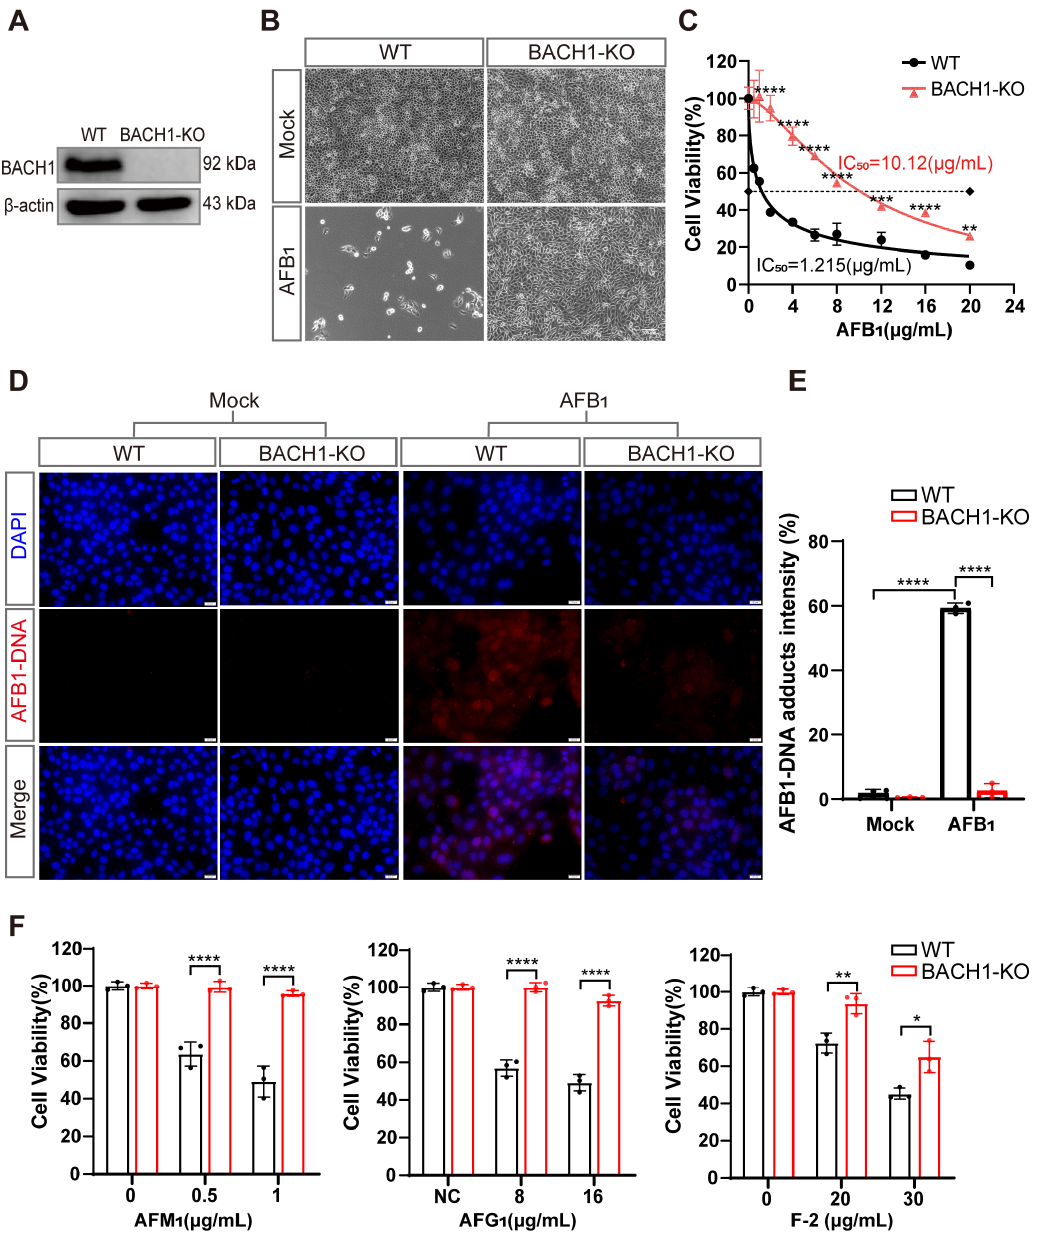
Figure 2. BACH1 knockout cells exhibit higher resistance to aflatoxin B 1 . ( A ) Western blot analysis of BACH1 expression in WT and KO cells. ( B ) Representative images of WT and BACH1-KO PK-15 cells challenged with 2 μ g/mL AFB 1 for 48 h. Scale bar, 100 μ M. ( C ) The IC 50 values for AFB 1 in WT and BACH1-KO cells determined by CCK-8 assays. ( D , E ) Immunofluorescence staining of AFB 1 -induced DNA adduct formation in WT and BACH1-KO cells; relative fluorescence intensity calculated using ImageJ software. Scale bar, 20 μ M. ( F ) Enhanced resistance to AFM 1 , AFG 1 , and F-2 in BACH1-KO cells. WT and BACH1-KO cells were treated with AFM 1 (at 0.5 μ g/mL and 1 μ g/mL), AFG 1 (at 8 μ g/mL and 10 μ g/mL), and F-2 (at 20 μ g/mL and 30 μ g/mL) for 36 h. Cell viability was measured with CCK-8 assays. * p < 0.05, ** p < 0.01, *** p < 0.001, **** p < 0.0001. p values were determined with two-tailed Student’s t-tests. AFB 1 , aflatoxin B 1 ; AFG 1 , aflatoxin G1; F2, zearalenone; WT, wild-type; KO, knockout.